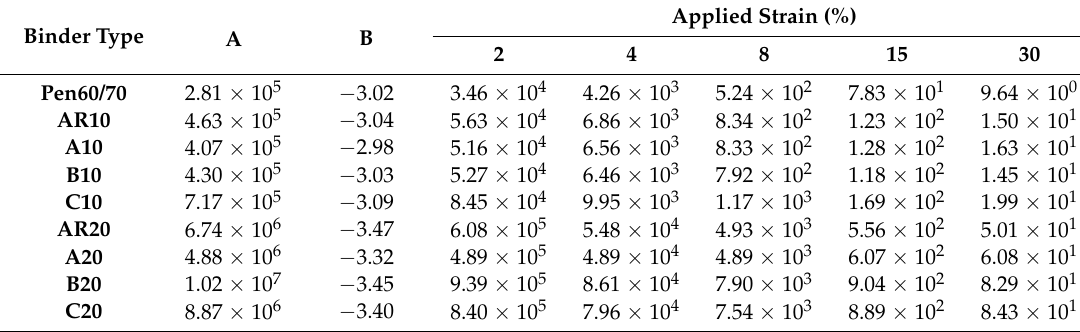
Table 5. LAS test